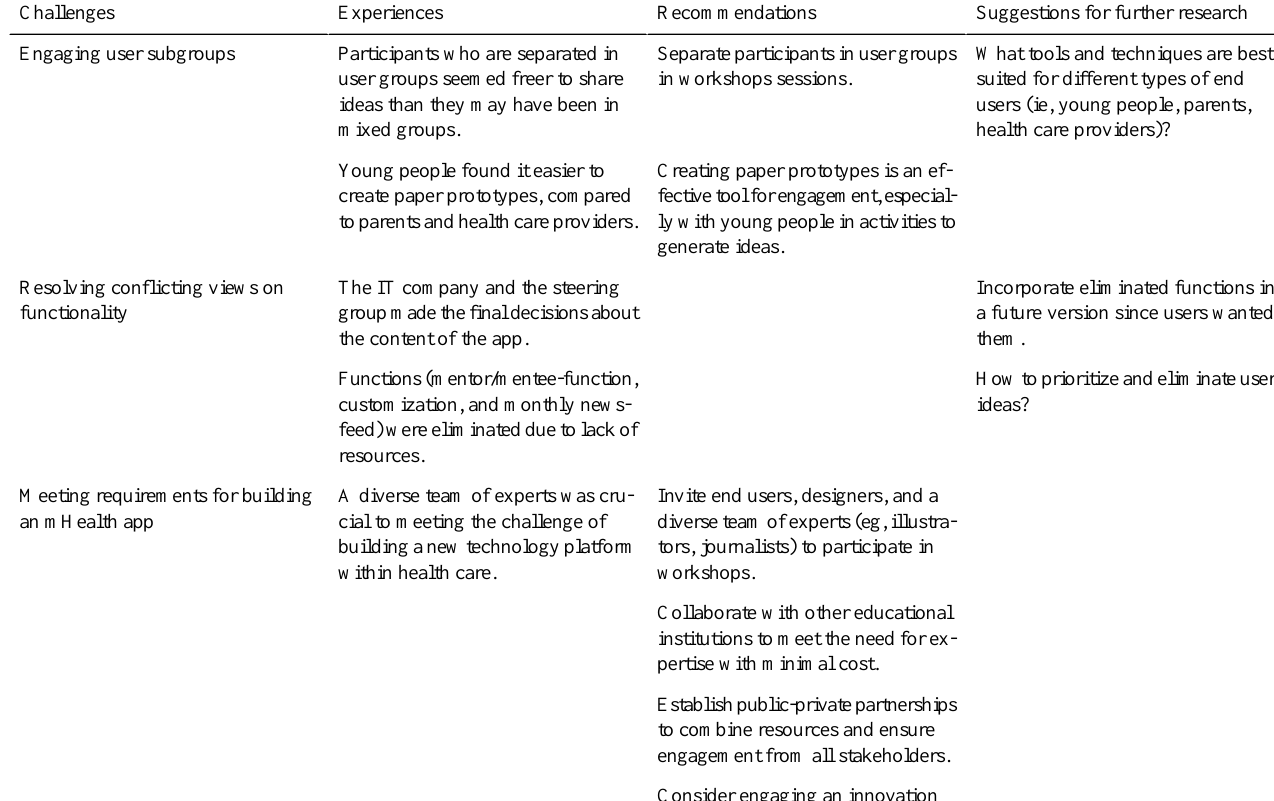
Table 3. Recommendations for future app